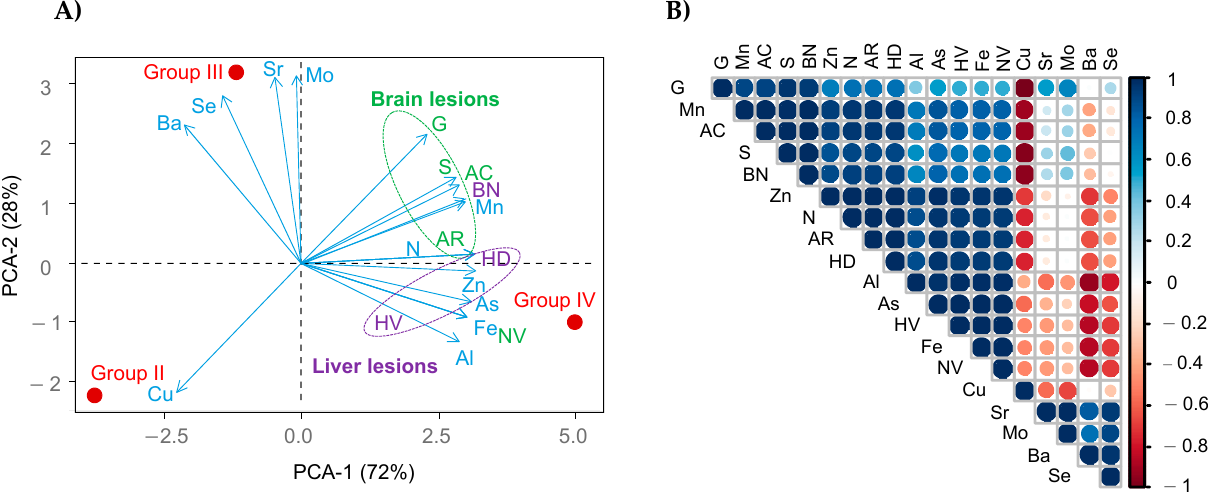
Figure 6. ( A ) Principal component analysis (PCA) loadings of metal(oid)s and liver/brain lesions in Groups II, III and IV. Abbreviations are angulated cells (AC), satellitosis (S), gliosis (G), axon retraction (AR), neuronal vacuolation (NV), hepatocyte vacuolation (HV), hepatocellular degeneration (HD), necrosis (N), binucleated cells (BC). ( B ) Correlation